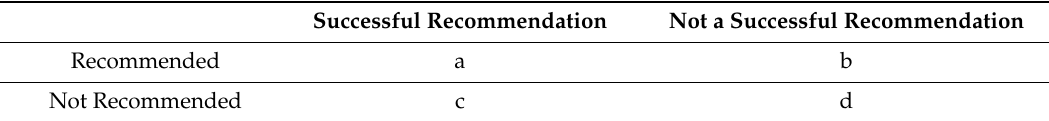
Table 1. Confusion matrix for a recommender